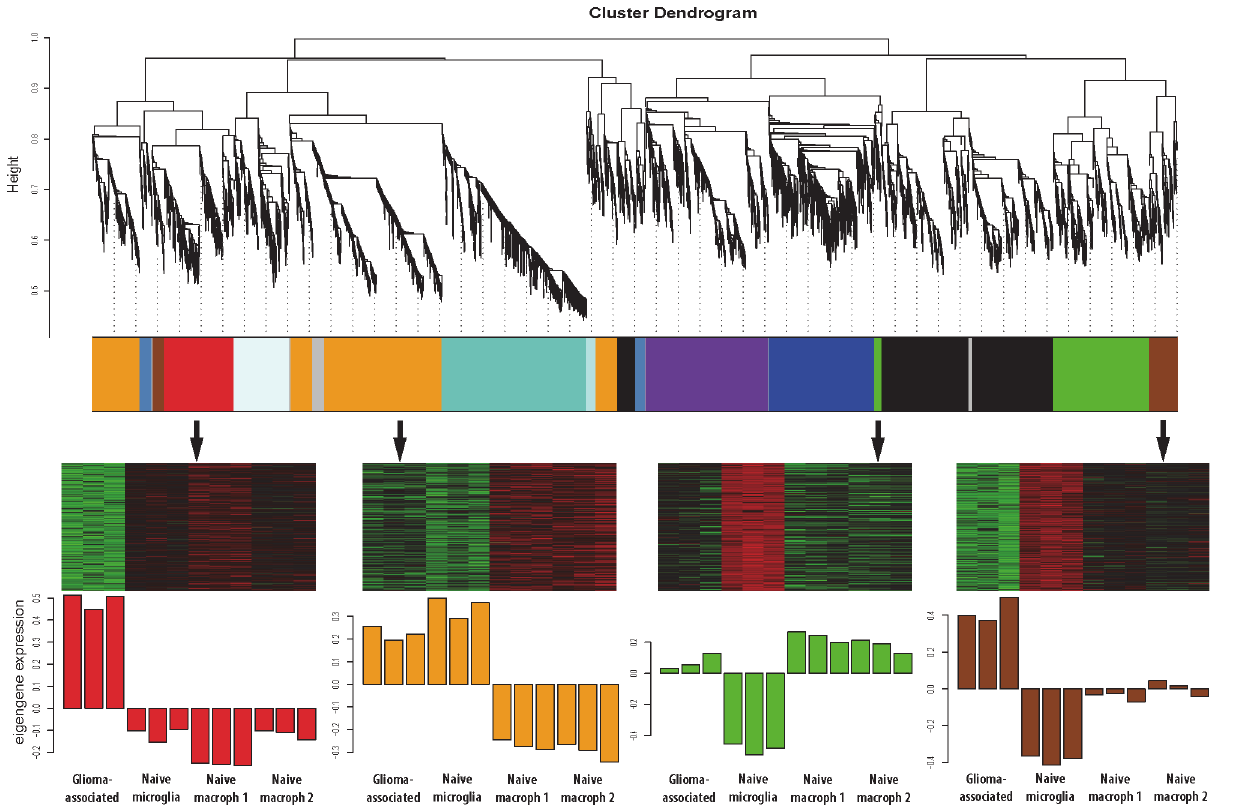
Fig 2. WGCNA gene clustering reveals glioma-regulated gene modules. Each color represents a different module and each module contains genes with similar expression patterns over all four sample sets. The glioma-regulated modules (labeled as red and brown) were further analyzed, as they contained genes that were upregulated in the glioma-associated set when compared to all three control sets. A third module (labeled as green module) contained genes that were highly expressed in GAMs when compared to na ï ve microglia, but were already highly expressed in peripheral macrophages. The module that is depicted as orange contains genes that were highly expressed in GAMs, and also highly expressed in na ï ve microglia, however expressed at lower levels in peripheral macrophages. All other clusters contained genes that did not seem to be